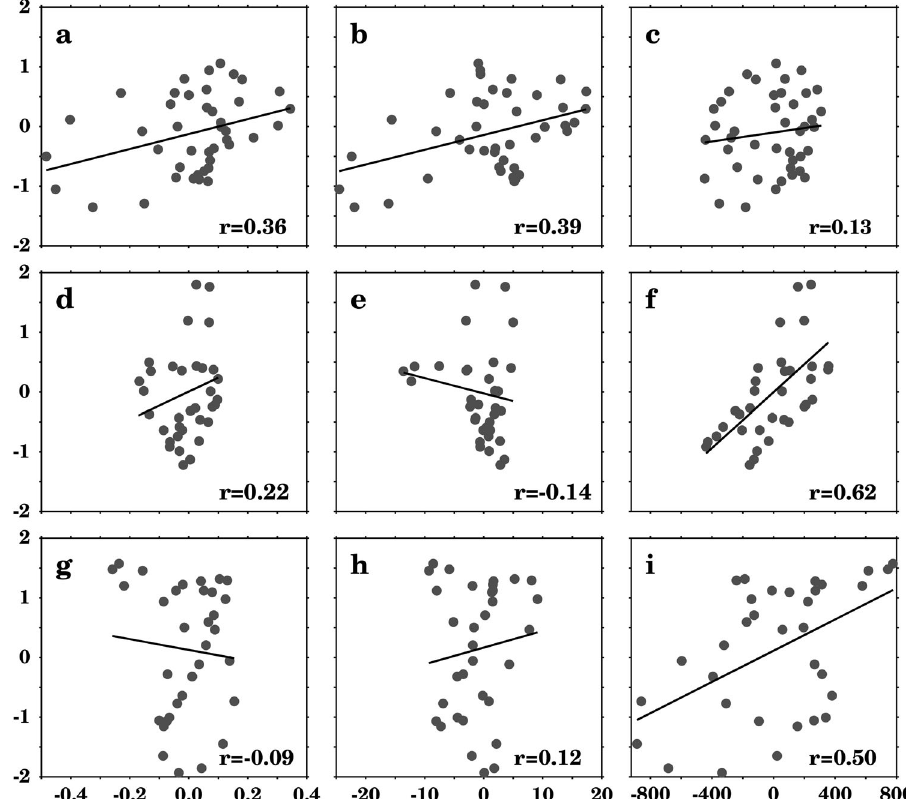
Fig. 7 Scatter analysis of WG rainfall variability against circulation and MSE. Scatter diagram of fi ltered anomalies of WG area-averaged (selected area shown in the Fig. 1) summer mean rainfall with summer mean a zonal wind (m/s) at 1000 hPa, b Relative Vorticity (*10 − 7 S − 1 ) at 1000 hPa, and c MSE (kJ/kg) averaged over the 1000 – 200 hPa for period 1; d , e , f for period 2 and g , h , i for period 3, respectively. The linear best fi t line is overlaid in each